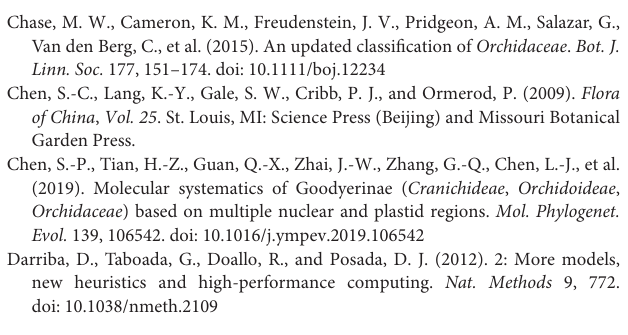
Supplementary Figure S1 | Complete plastid genome maps of Goodyera species and Spiranthes sinensis . Genes shown inside the circle are transcribed clockwise, and outside are counterclockwise. Genes belonging to different functional groups are colored. The inner circle shows the LSC, SSC, and IR regions. The darker gray in the inner circle corresponds to GC content, and the lighter gray corresponds to AT content. Supplementary Figure S2 | The alignment of plastid genome sequences based on mVISTA. Plots of percent sequence identity of the plastid genomes of 20 Goodyera clade species with Anoectochilus emeiensis as a reference. The percentage of sequence identities was estimated, and the plots were visualized in mVISTA. CDS means coding sequences and CNS means non-coding sequences. Supplementary Figure S3 | Comparisons of LSC, SSC, and IR regions boundaries between 20 species of Goodyera clade. Supplementary Figure S4 | The maximum likelihood tree of 31 orchids inferred from 14 plastid protein-coding gene datasets. Numbers indicate support